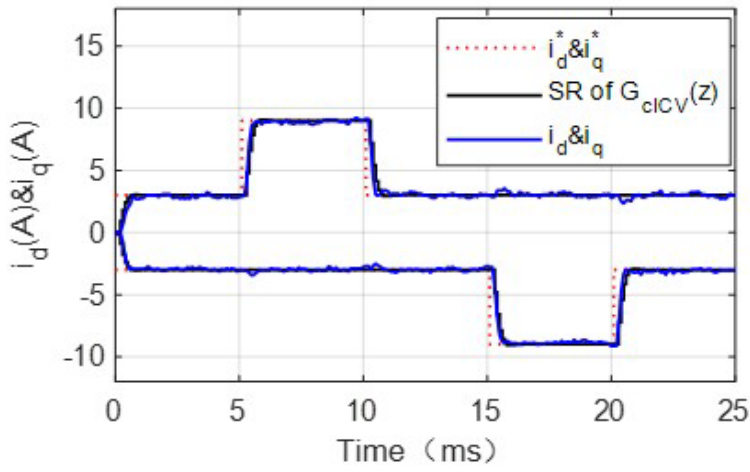
Figure 19. Experiment result of complex vector controller based on flux-linkage data ( k = 0.3, f s = 10 kHz ) of the high-speed machine ( f out = 833 Hz).